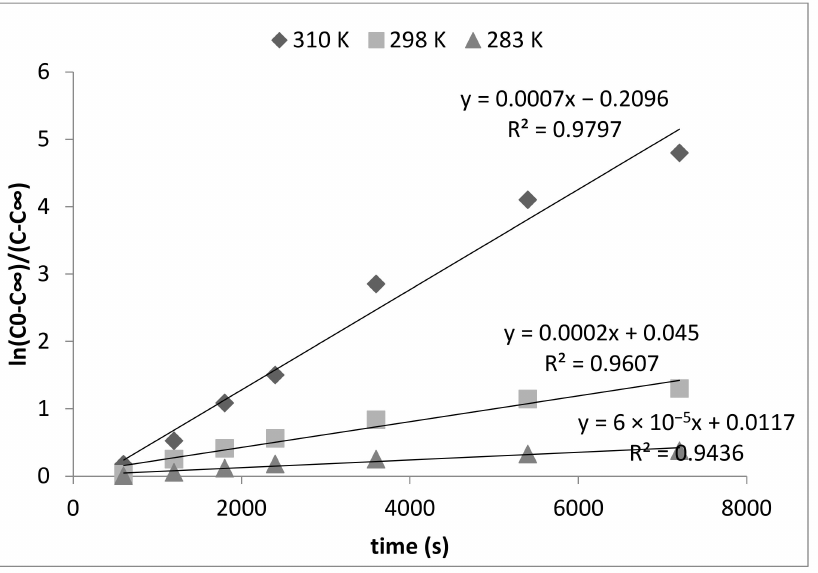
Figure 5. Logarithmic anamorphoses of kinetic curves of fluoride ions absorption from solution by the bacterial cellulose-based modified